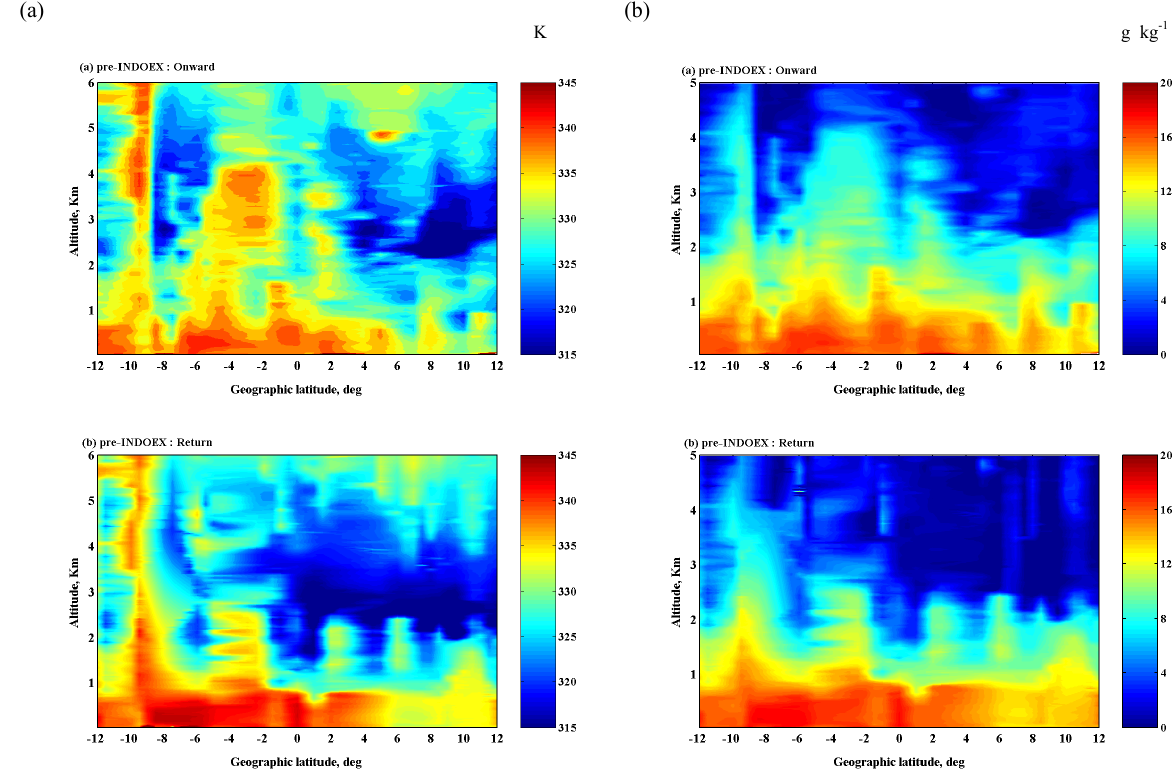
Fig. 5. Contour plots of (a) equivalent potential temperature and (b) mixing ratio over the entire latitude range during pre-INDOEX. The boundary between red and blue is the trade wind inversion layer.